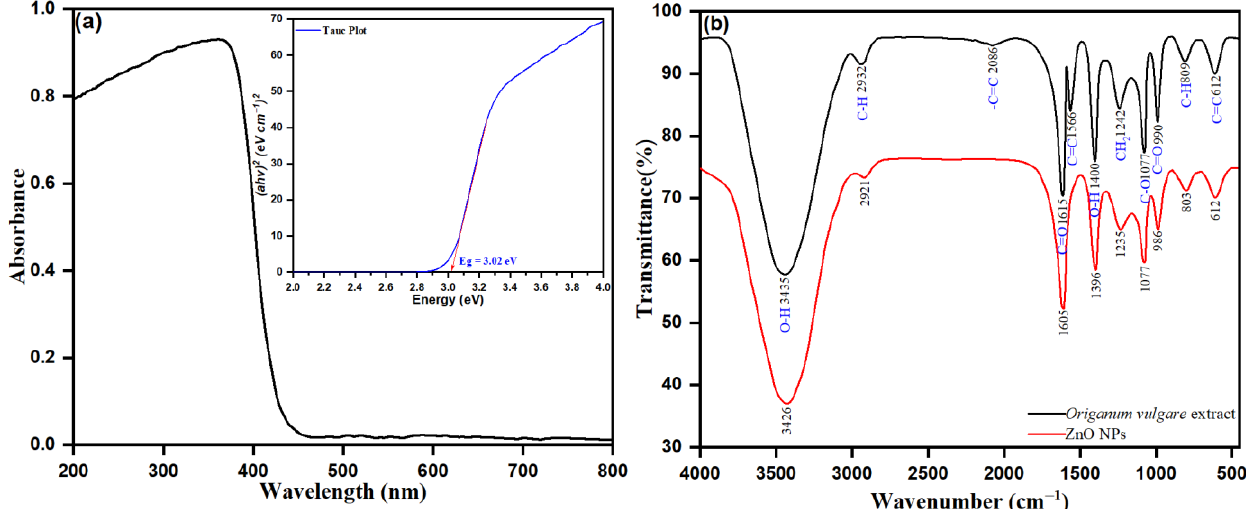
Figure 6. ( a ) UV-Vis absorption spectrum (inset shows corresponding Tauc plot) and ( b ) FTIR spectrum of ZnO NPs.